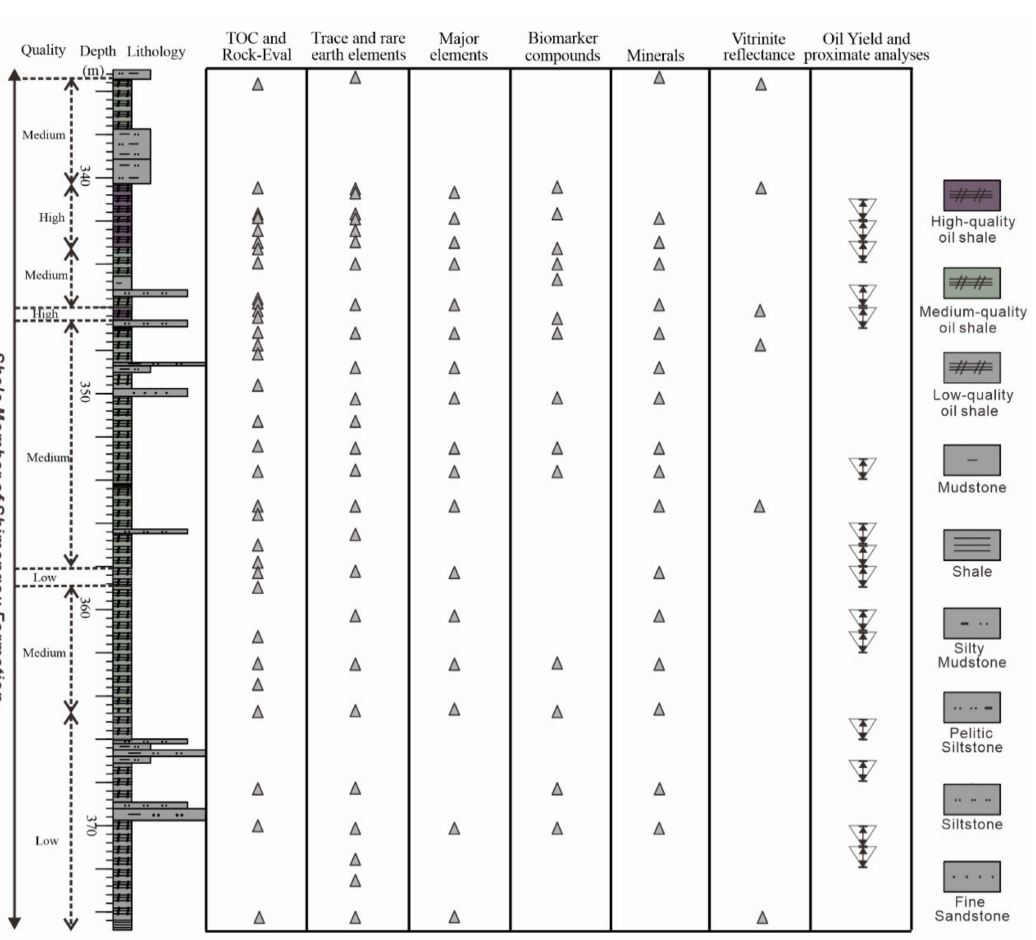
Figure 2. Vertical distribution of samples from the Shale Member of the Shimengou Formation, YYY-1